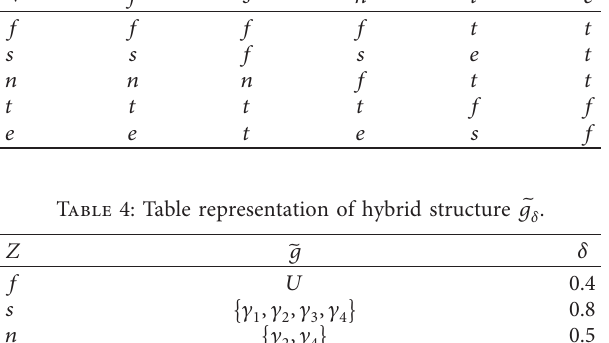
Table 3: Cayley table of the binary operation ∗ . ∗